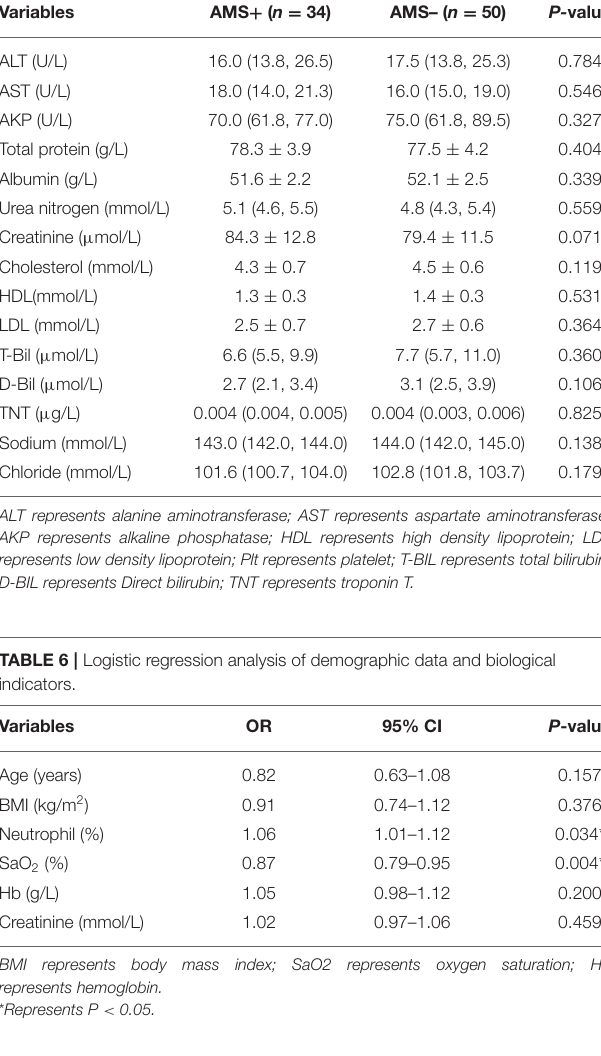
TABLE 4 | Comparison of blood routine test results at high altitude between two groups of volunteers. Variables